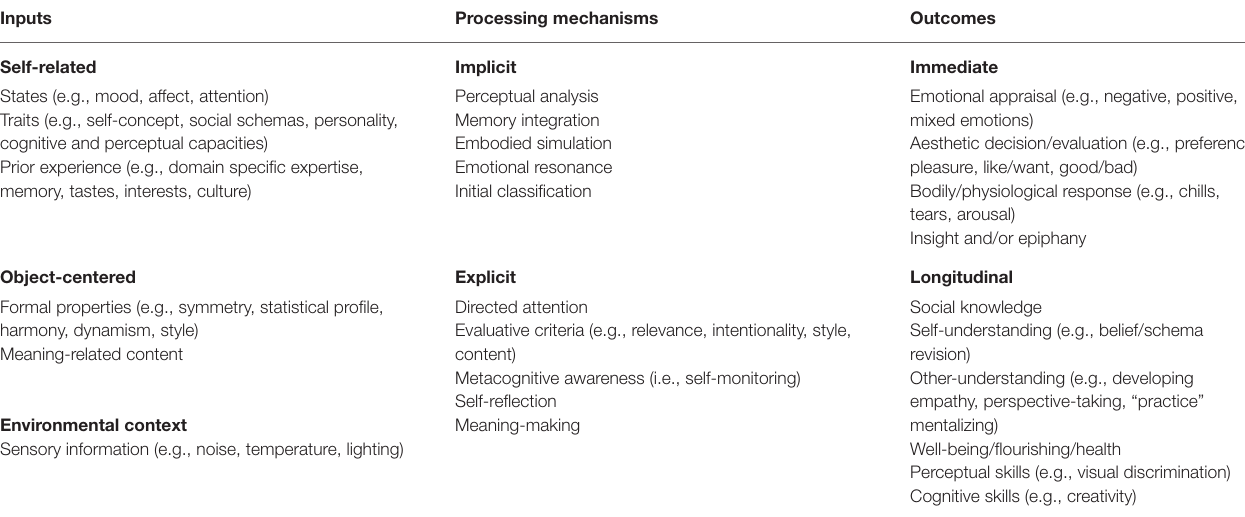
TABLE 1 | Factors influencing art